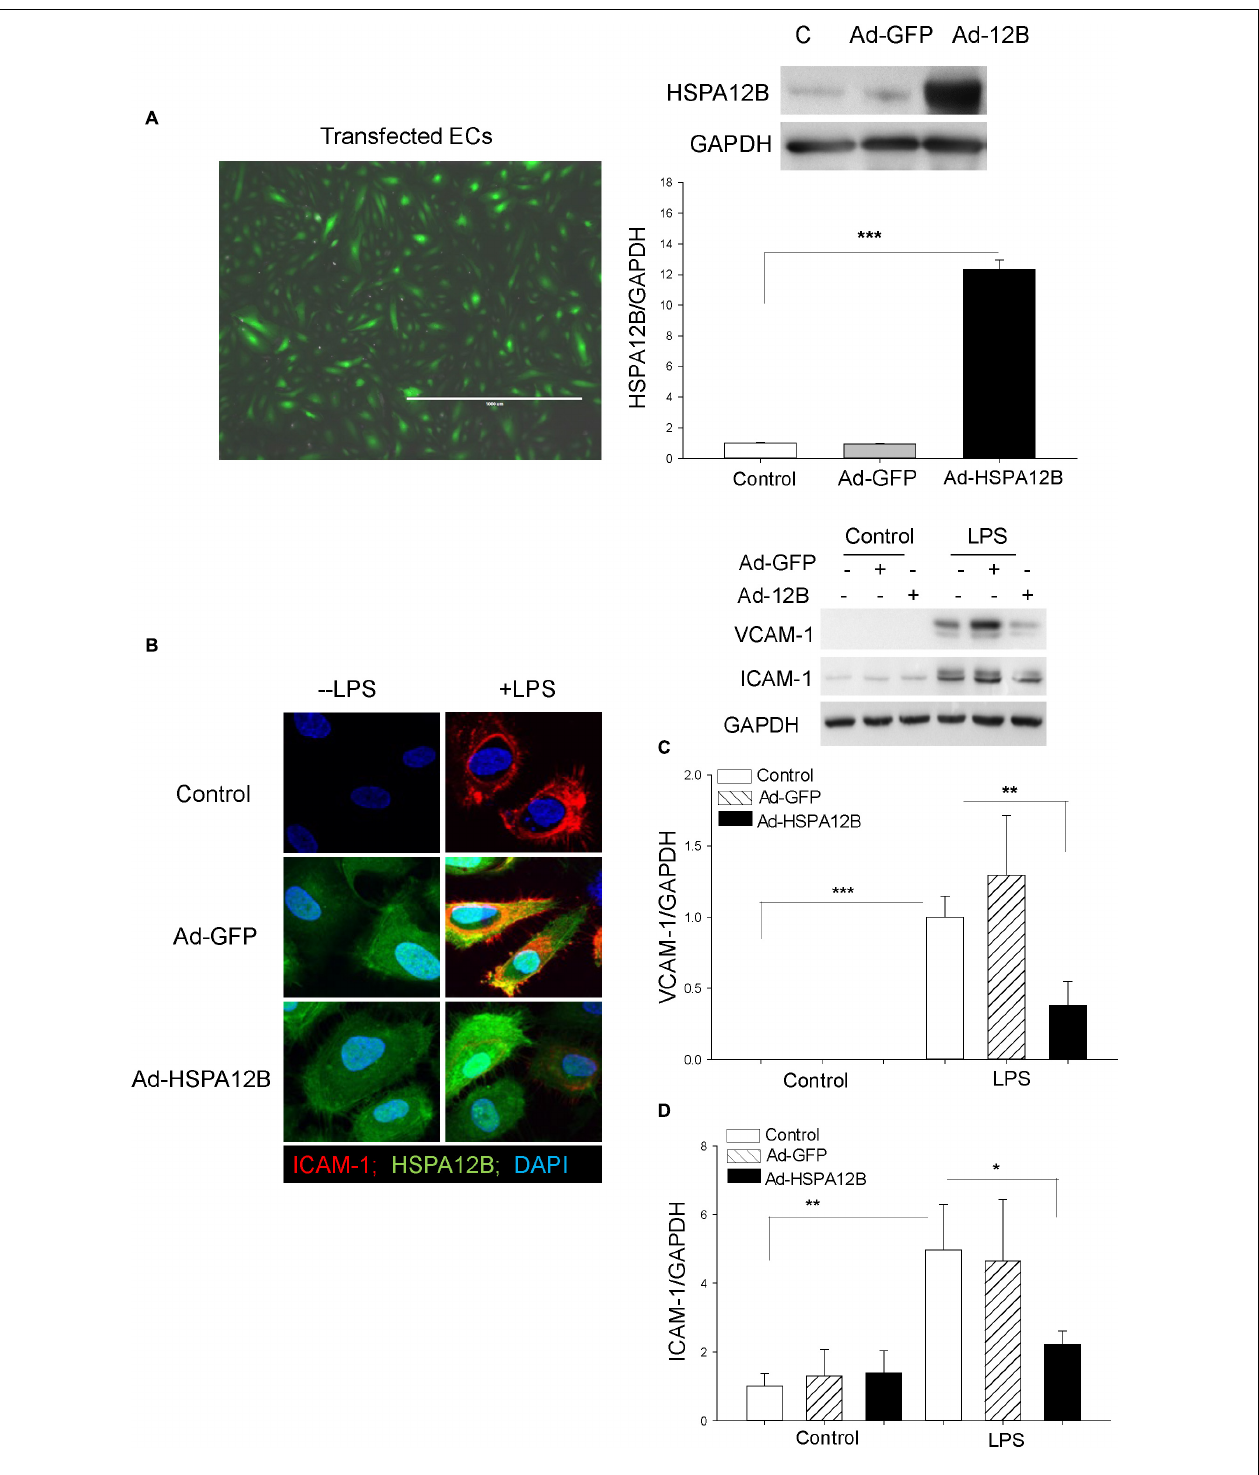
FIGURE 3 | HSPA12B attenuates LPS-induced expression of adhesion molecules in ECs. Endothelial cells (HUVECs) were transfected with adenovirus-expressing HSPA12B (Ad-HSPA12B) or Ad-GFP 24 h before the cells were stimulated with LPS. (A) Green color indicates Ad-HSPA12B transfected into the HUVECs. Western blot shows that transfection of HUVECs with Ad-HSPA12B increased the levels of HSPA12B. (B) Confocal microscopy examination (66 × ) shows that Ad-HSPA12B transfection attenuates LPS-induced ICAM-1 (red color) expression in HUVECs. Green color indicates HSPA12B; blue color indicates nucleus stained with DAPI. (C,D) Western blot shows that Ad-HSPA12B transfection significantly suppressed LPS-induced VCAM-1 (C) and ICAM-1 (D) expression in HUVECs. n = 3/groups. * P < 0.05; ** P < 0.01; *** P < 0.001 compared with indicated groups.